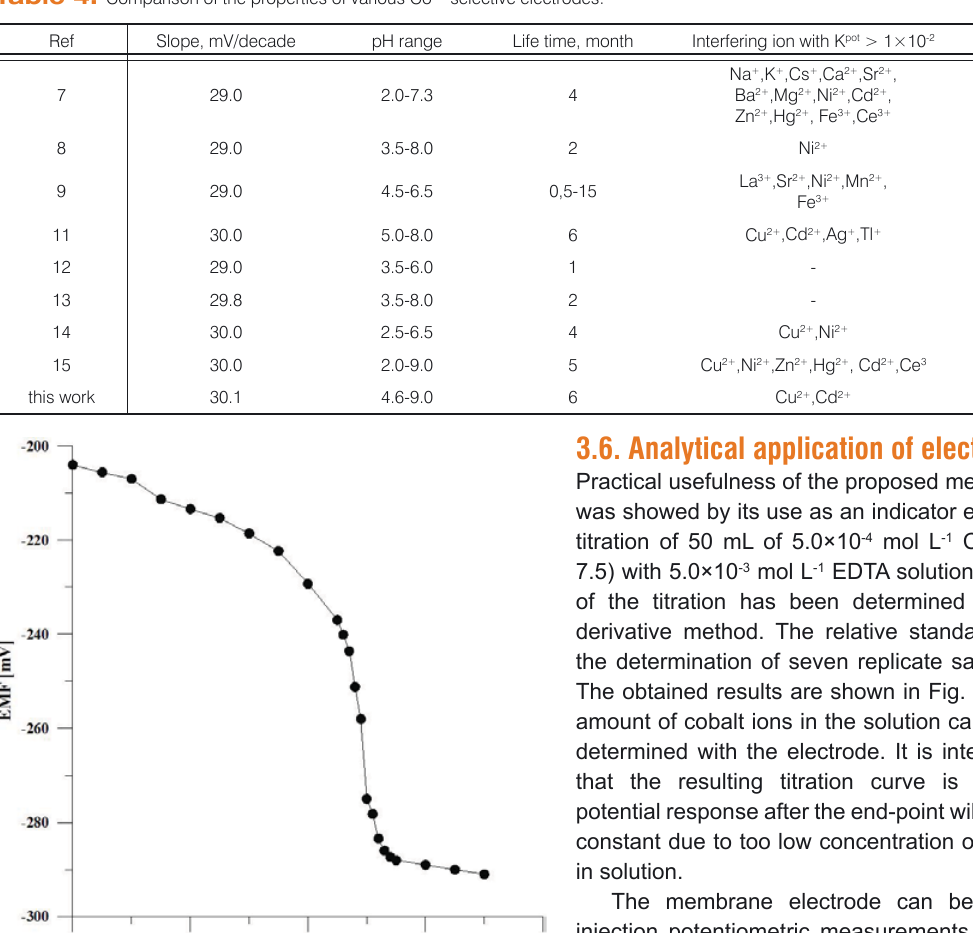
Table 4. Comparison of the properties of various Co 2+ selective